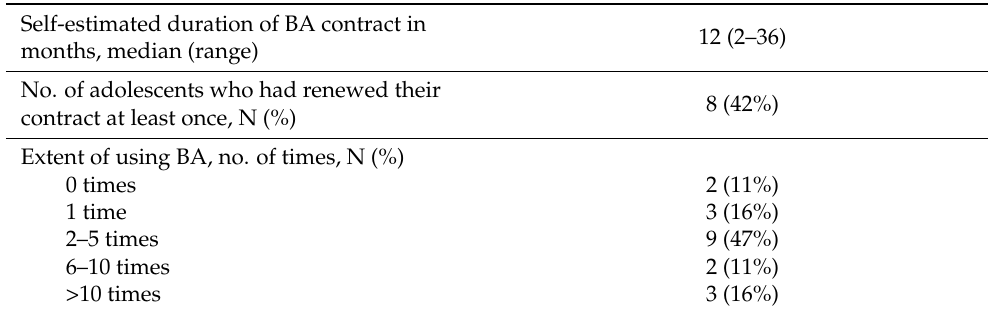
Figure 1. Flowchart of adolescents contacted, informed, and interviewed. * Legal gender was defined by the second to last digit in the Swedish national identification number. Table 1. Duration of contract, contract renewal and extent of use of BA according to information provided by adolescents who were interviewed about experiences of access to BA (n =